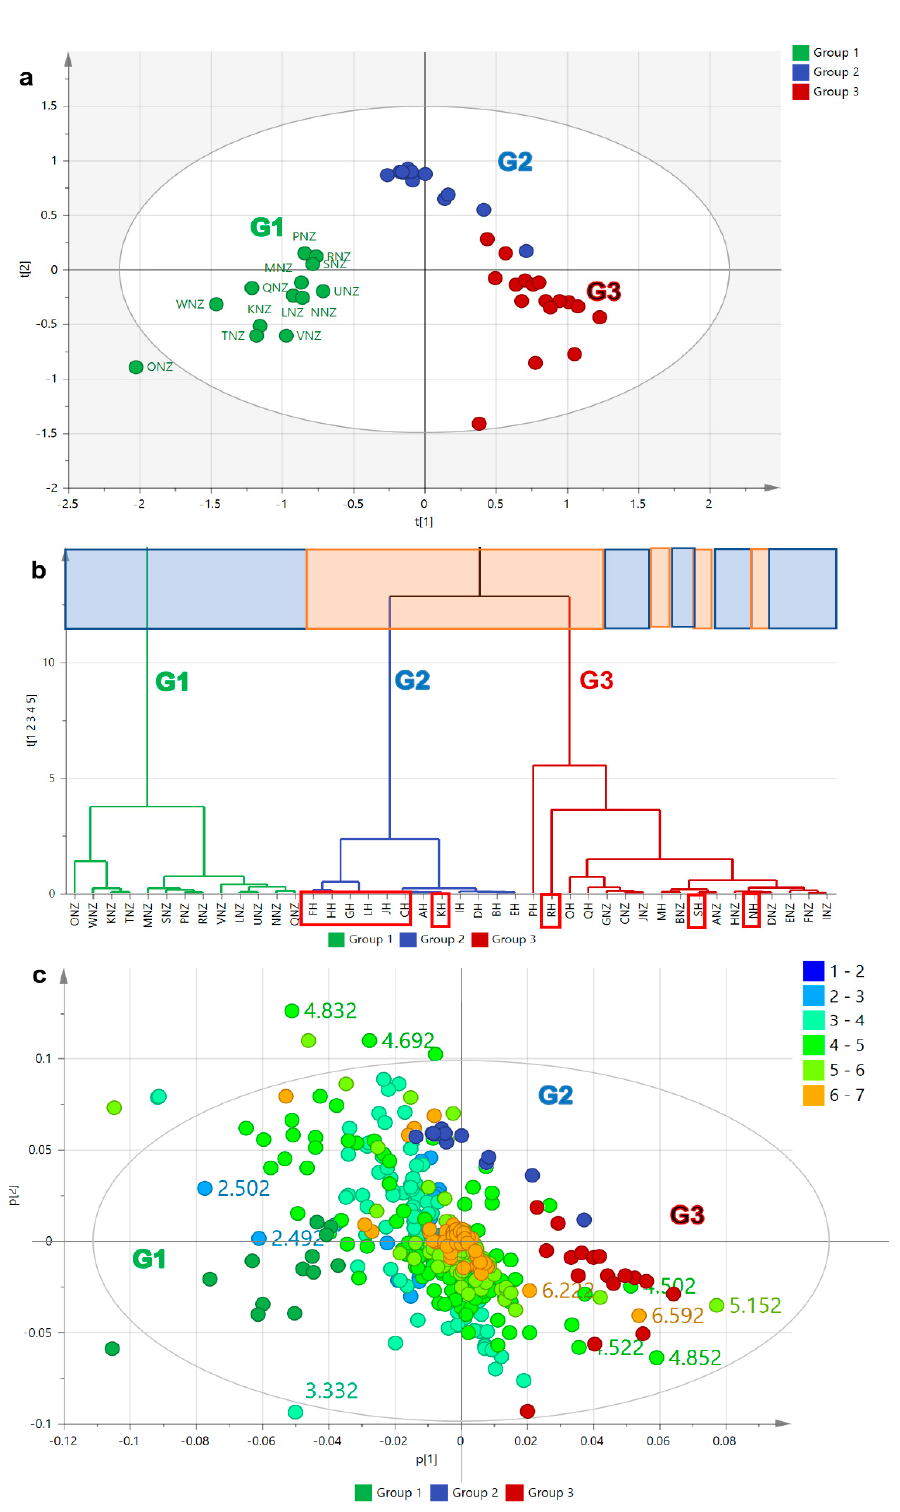
Figure 4. PCA model employing fused NMR and mass spectral datasets. ( a ) Scores and ( b ) HCA plots on honey extracts based on HR-LCMS and 1 H NMR fusion which gave a fitness R 2 value = 0.715 and predictive ability Q 2 = 0.413. ( c ) PCA-biplot of the scores and extracted NMR loadings plot from the fused datasets. Bioactive samples were boxed in red. Highlighted upper boxes on HCA dendrogram ( b ) represents origin of honey samples where blue represents the New Zealand (NZ) samples while the Malaysian samples were highlighted in